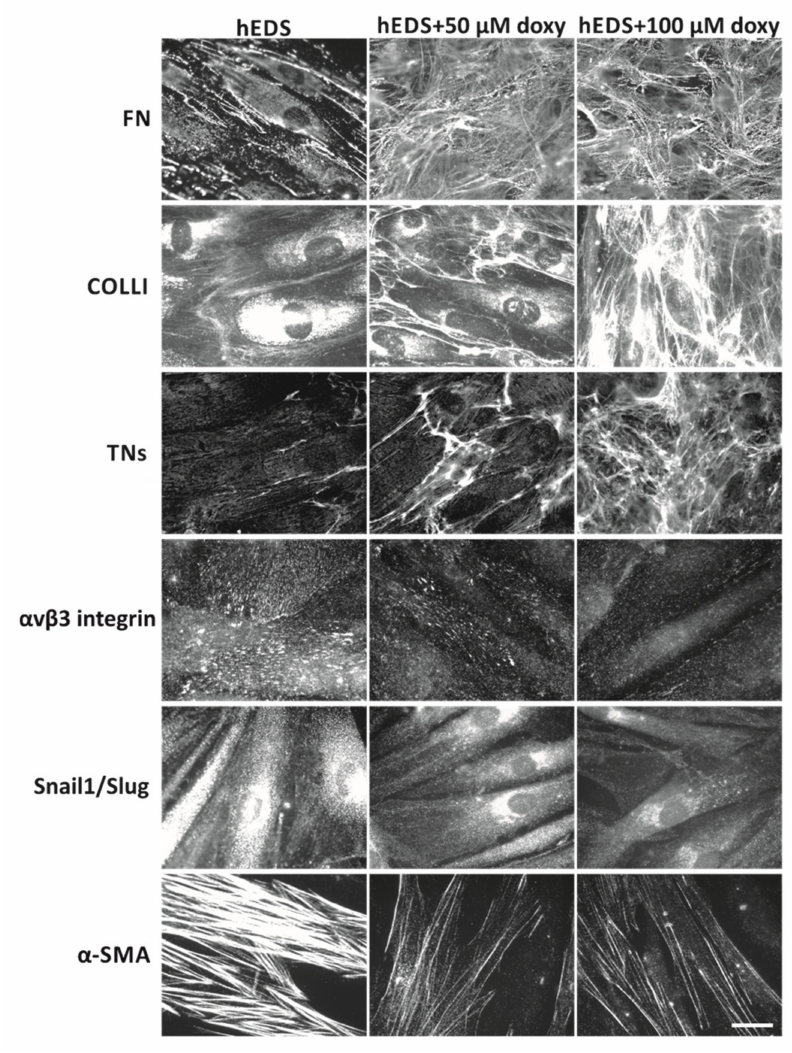
Figure 3. Effect of doxycycline (doxy) on ECM disarray and myofibroblast differentiation in hEDS cells. IF analyses of FN-, COLLI-, and TNs-ECM organization, α v β 3 integrin and Snail1/Slug transcription factor expression, and α -SMA cytoskeleton assembly in hEDS fibroblasts untreated and treated with 50 and 100 µ M of doxy in complete MEM for 2 (FN and α v β 3 integrin), 4 (COLLI and TNs), 6 ( α -SMA), and 8 (Snail1/Slug) days. The images are representative of 6 different patients’ cell strains. Scale bar: 12 µ